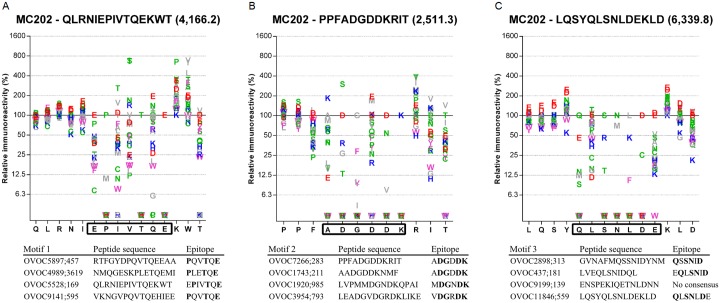
Epitope mapping of peptides with one of three motifs.Amino acid plots using sample MC202 for peptides OVOC5528;169 (A), OVOC7266;283 (B), and OVOC11846;559 (C). Amino acid residues comprising the epitope are indicated by the rectangle on the x-axis. Consensus epitopes determined in 5 samples for the 4 selected peptides for each motif are listed below the plots. Residues indicated in bold represent amino acids essential for antibody binding.